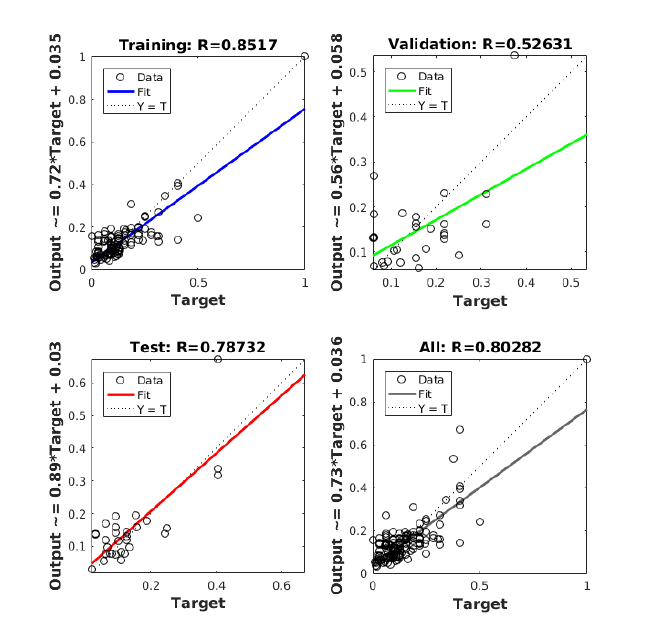
Figure 12. Regression results (target vs. predicted solution time) for one training, validation, test part of the Dice 2 dataset and for the whole dataset ( N h =